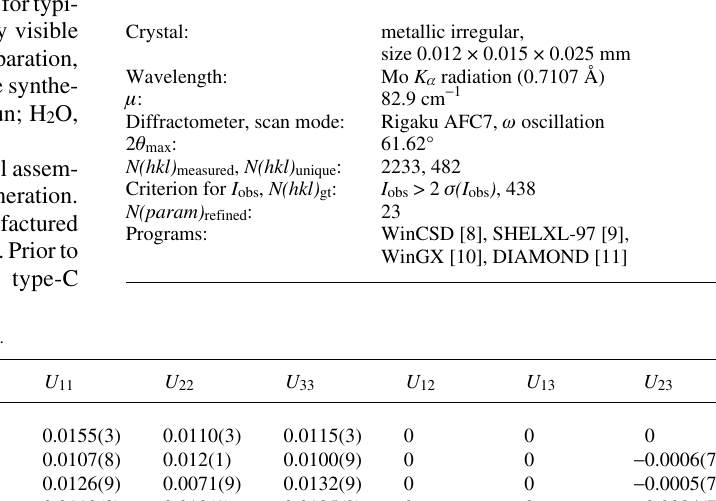
Table 1. Data collection and handling.